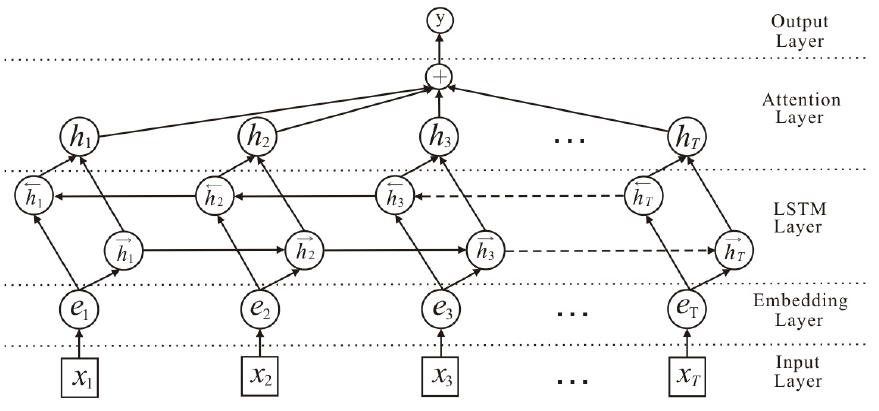
Figure 3. The bidirectional LSTM model with attention [67].